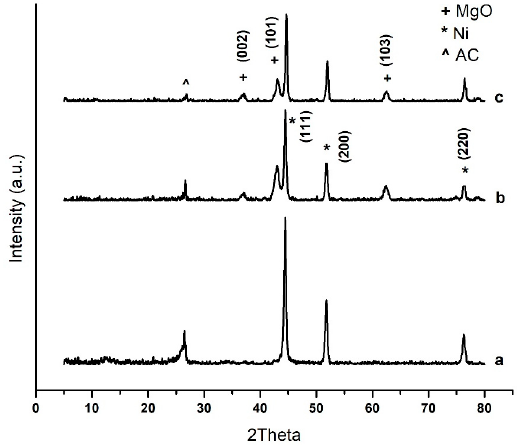
Figure 1. XRD profile of ( a ) 10Ni / AC, ( b ) NiMgO / AC, and ( c ) Ni / MgO / AC.